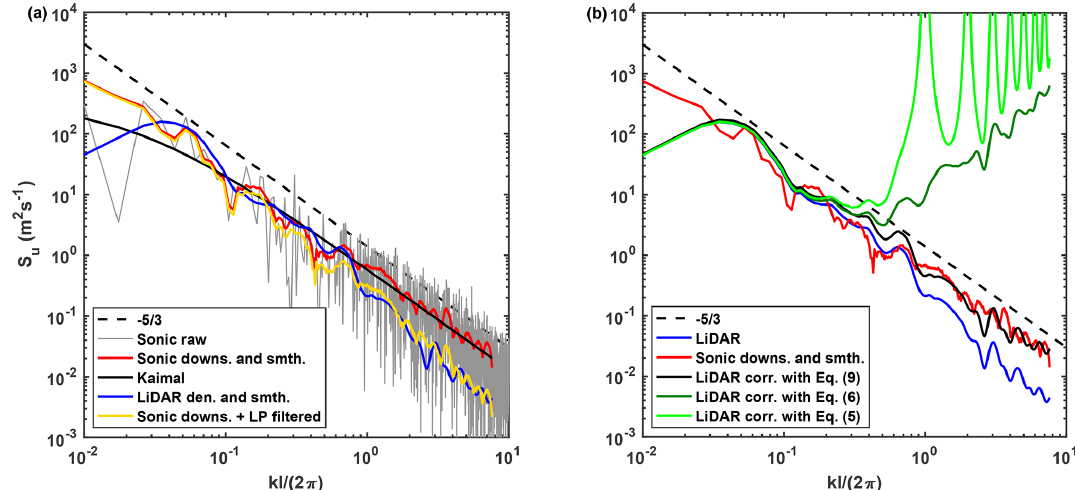
Figure 5. Comparison of lidar velocity data against sonic anemometry data for the XPIA dataset: (a) raw sonic anemometer data (gray), down- sampled and smoothed sonic anemometer (red), Kaimal model (black) tuned on the lidar velocity spectrum (blue), and sonic anemometer signal down-sampled and low-pass filtered (yellow); (b) lidar velocity spectrum (blue), down-sampled and smoothed sonic anemometer spectrum (red), and lidar spectrum corrected with Eqs. (9), (5), and (6) (black, bright green, and dark green lines, respectively).